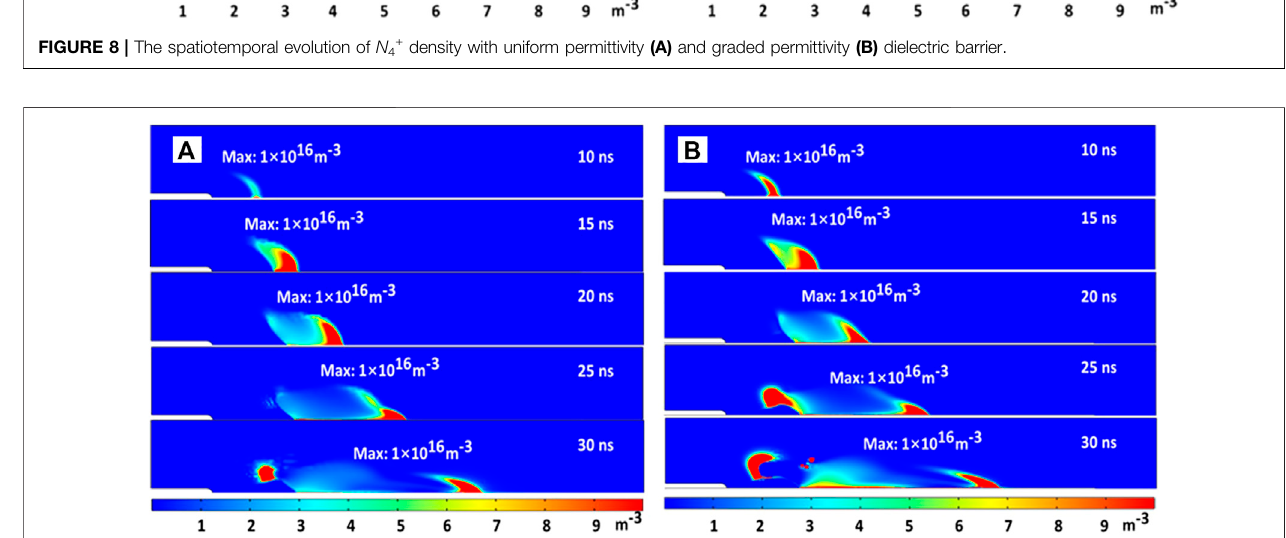
Frontiers in Physics |